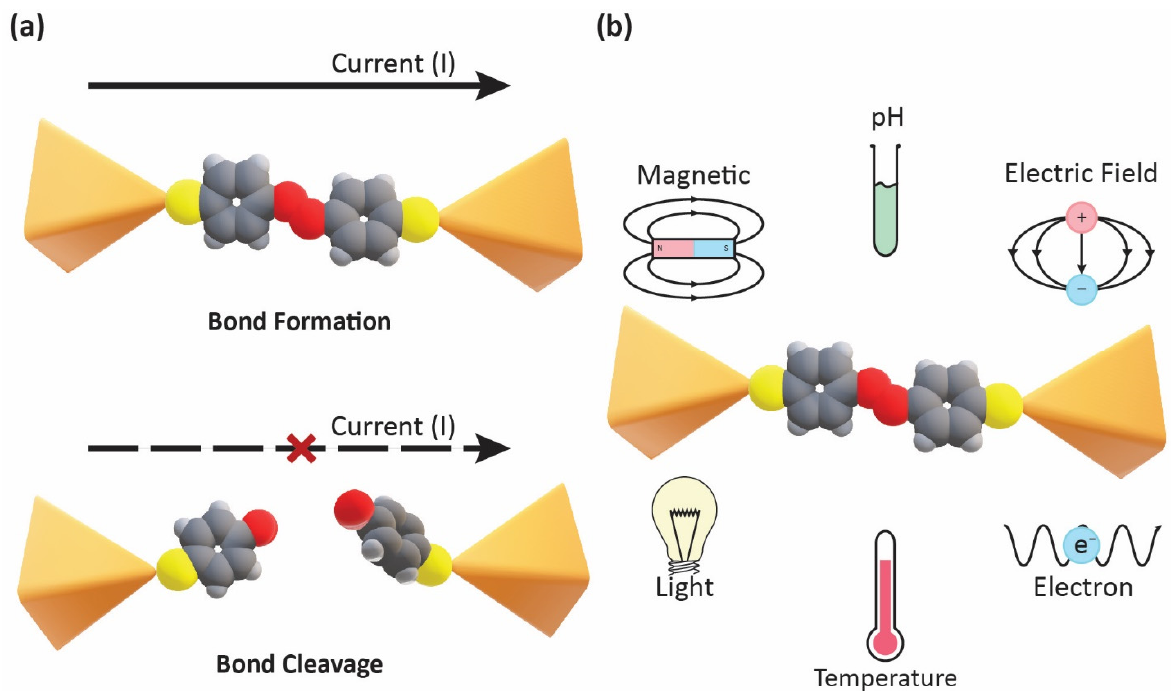
Figure 1. Probing a chemical reaction at the single-molecule level: ( a ) schematic illustration of bond formation and cleavage; ( b ) stimuli-induced chemical reaction.